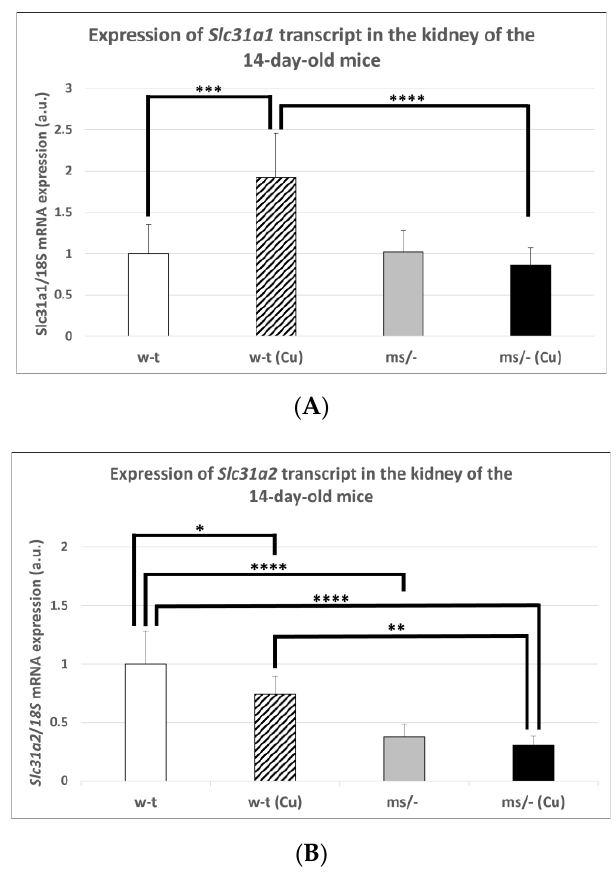
Figure 1. Expression of Slc31a1 ( A ) and Slc31a2 ( B ) genes in the kidney of the suckling (14-day-old), w-t and mosaic mutant mice. The histograms display mRNA levels in arbitrary units (means ± S.D., n = 5, (* p < 0.05, ** p < 0.01, *** p < 0.001, **** p < 0.0001). n = 5, (* p < 0.05, ** p < 0.01, *** p < 0.001, **** p <